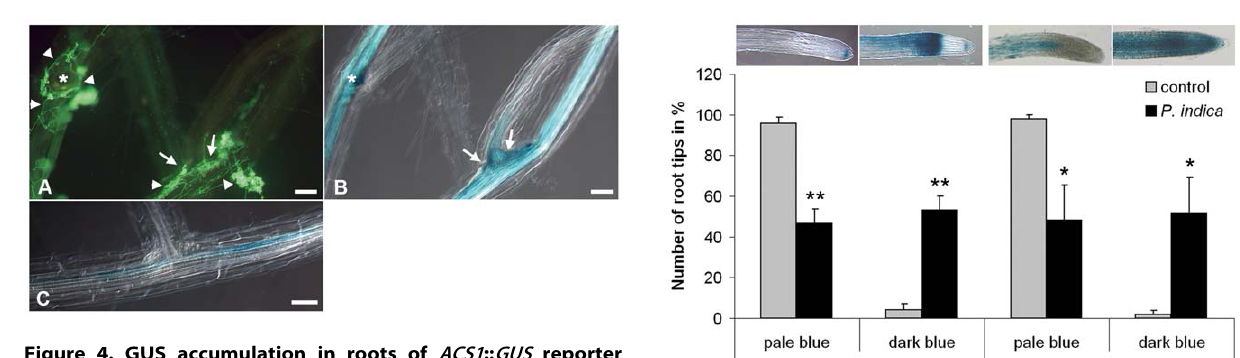
Figure 4. GUS accumulation in roots of ACS1 :: GUS reporter plants colonized by P. indica . Arabidopsis line ACS1 :: GUS was harvested at 7 dai and, after GUS and WGA-AF 488 staining, analyzed cytologically. ( A , B ) P. indica colonization at the base of lateral roots (arrows) or primordia (asterisks) of line ACS1 :: GUS was associated with enhanced GUS accumulation. P. indica (arrowsheads in A) was visualized by staining with WGA-AF 488. ( C ) In mock-treated ACS1 :: GUS , GUS staining was weakly detectable e.g. at the lateral root base. Bars=60 m m.